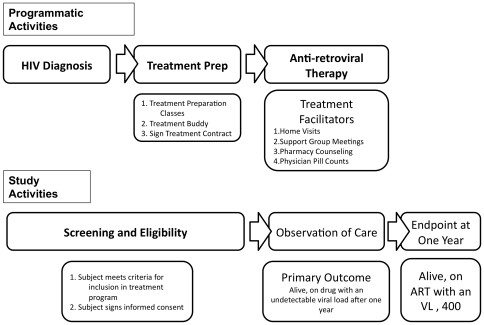
Schematic Diagram of HIV Program and Observational Study Design.The HIV program is divided into 3 distinct activities, HIV testing, Treatment Preparation, and Antiretroviral treatment that includes both community and clinic based facilitators. For entry into the study, subjects must be HIV positive and complete all treatment preparation activities. The study period begins with initiation of ART and evaluates the effects of treatment facilitators on treatment success.